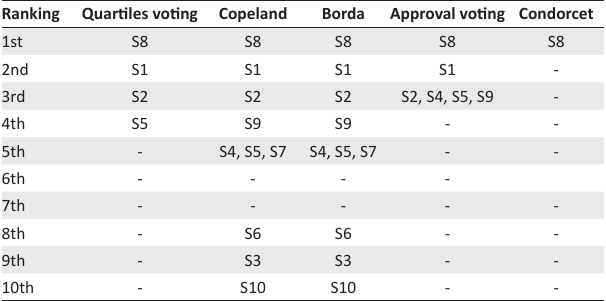
TABLE 15: Comparison of the results obtained by applying the Copeland, Borda, Approval voting and Condorcet procedures.